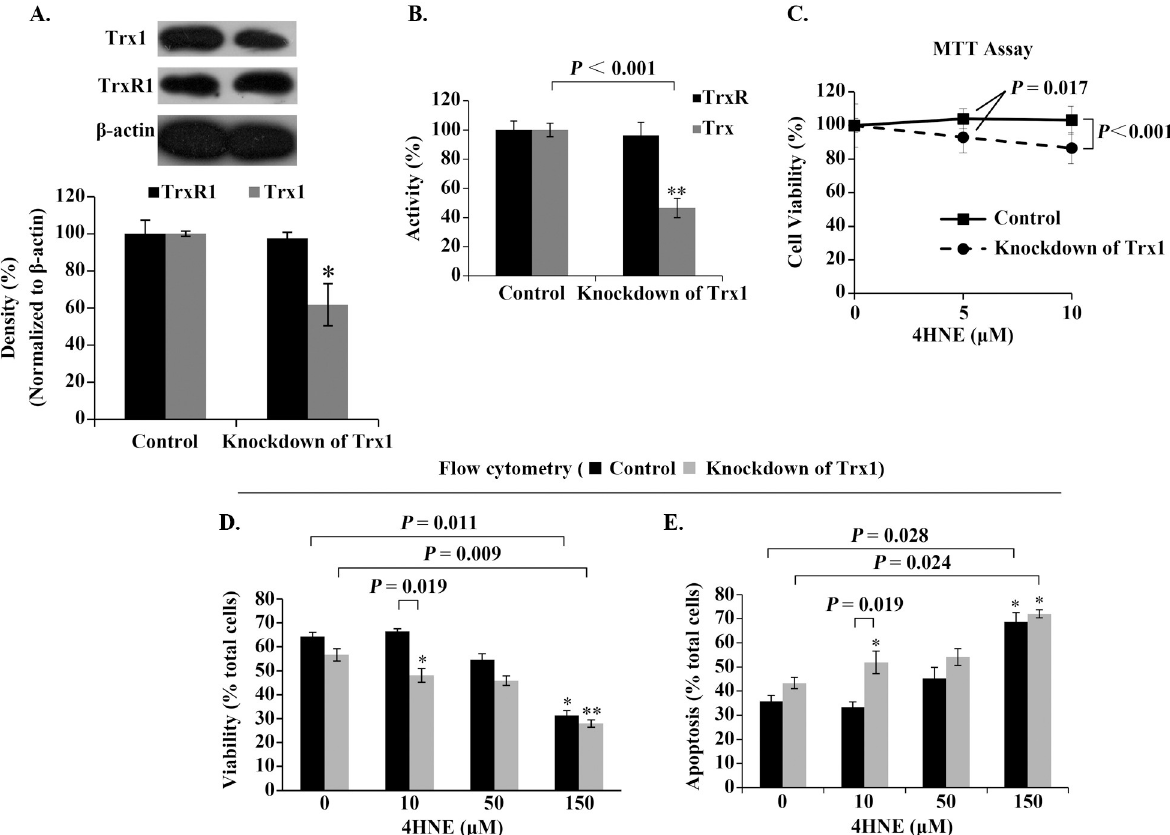
Fig 5. Role of cellular Trx1 in mediating the effect of extracellular 4HNE on cell survival. ( A ) Analysis of Trx1-knockdown efficiency. β -actin was used as an internal reference. Representative Western blots (upper panel) and relative density values (bottom panel) for the bands in the upper panel. ( B ) Activities of cellular Trx/TrxR. ( C ) Trx1-Knockdown decreased the ability of the cells against 4HNE. ( D,E ) Analyses of the cell viability and death by flow cytometer. In the bar or curve graphs, the values are expressed as mean ± S.D. (n � 3). � , P < 0.05; �� , P < 0.01.